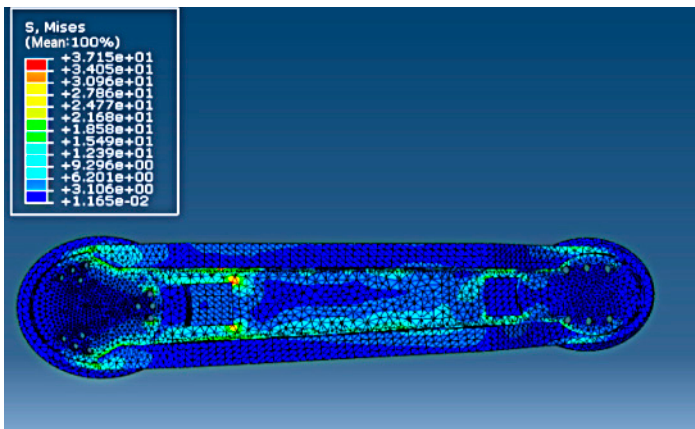
Figure 7. The Mises stress cloud map under static load in ABAQUS. Metals 2019 , 9 , x FOR PEER REVIEW